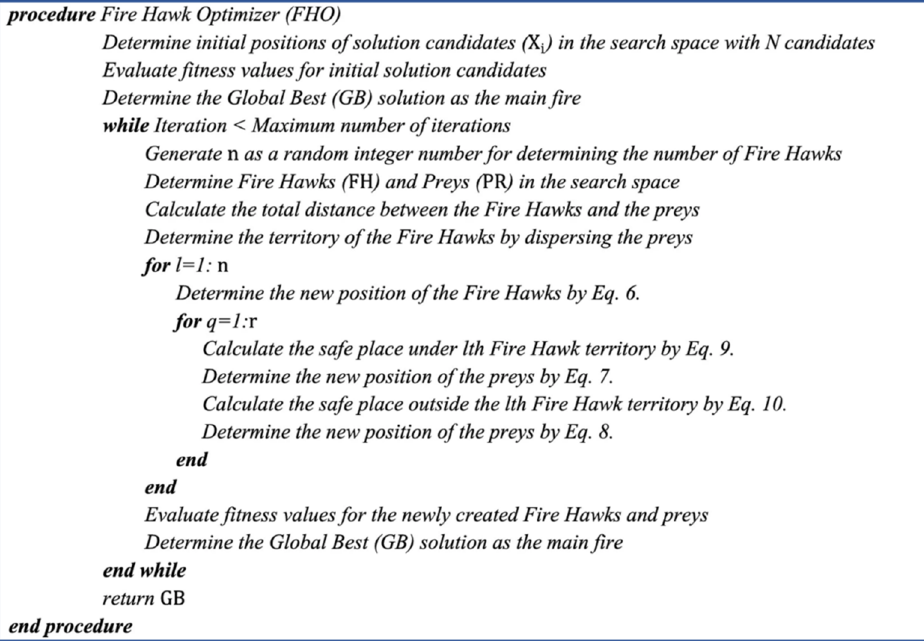
Figure 3. Pseudo-code of